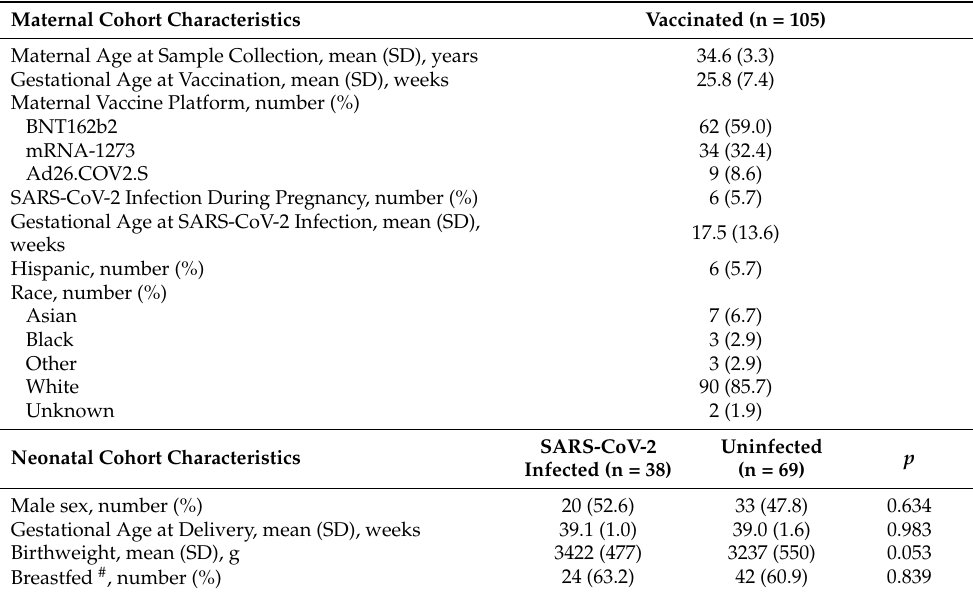
Table 1. Demographics of the vaccinated maternal cohort and their infants. To assess for differences between SARS-CoV-2 infected and uninfected neonatal cohorts, continuous outcomes were analyzed by Mann–Whitney U test and dichotomous outcomes were analyzed by Fisher’s Exact test. The maternal cohort was n = 105 and the neonatal cohort was n = 107 due to two sets of twins. Maternal Cohort Characteristics